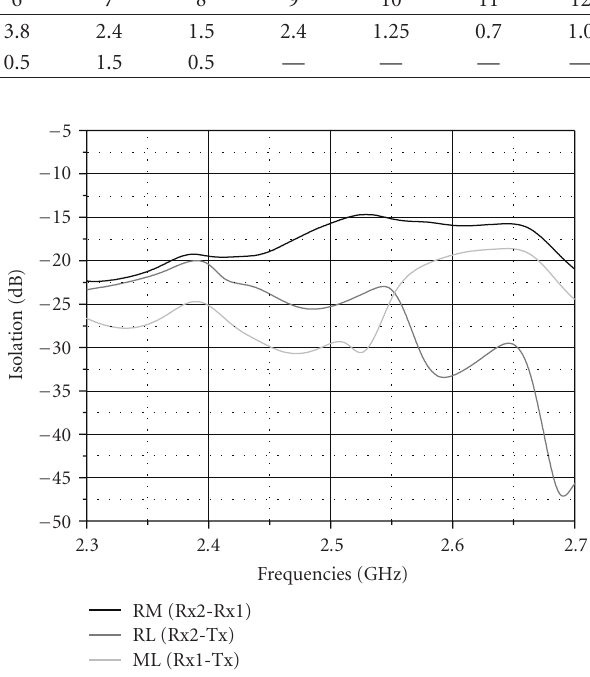
Figure 20: Isolation between antennas for the three-antenna configuration.